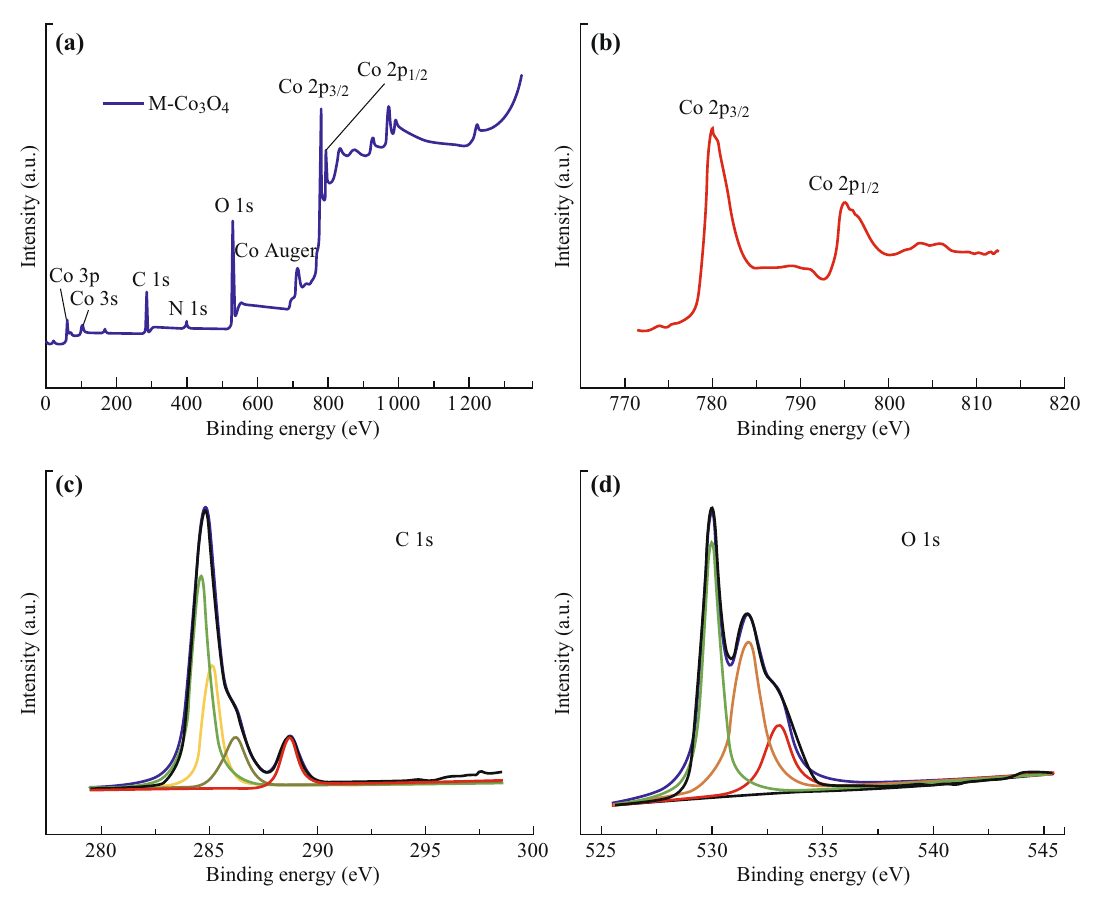
Fig. 7 a Full XPS spectrum of M-Co 3 O 4 /NPC, deconvoluted spectra of b Co 2 p , c C 1 s , and d O 1